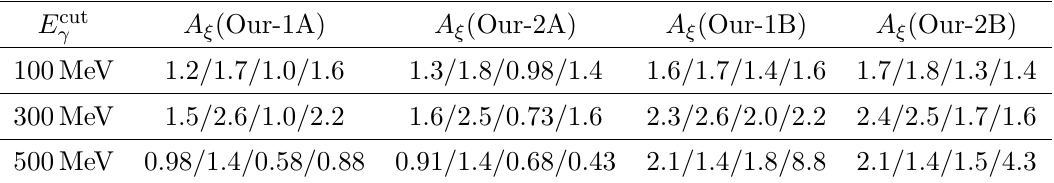
Table 2 . Rates of the triple-product asymmetry with different photon energy cutoffs. All the numbers except those in the first column are multiplied by the factor of 10 − 2 . The meanings of different notations and the way to obtain the four numbers in each entry in the last four columns are the same as those in table